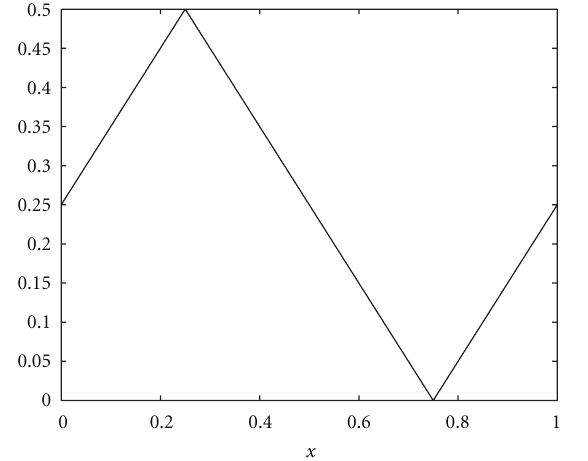
Figure 3: The graph of 𝑓(𝑥) of Example 2.